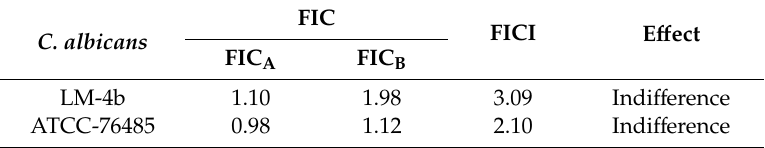
Table 3. Association between isoeugenol and nystatin on C. albicans ATCC-76485 and LM-4b.